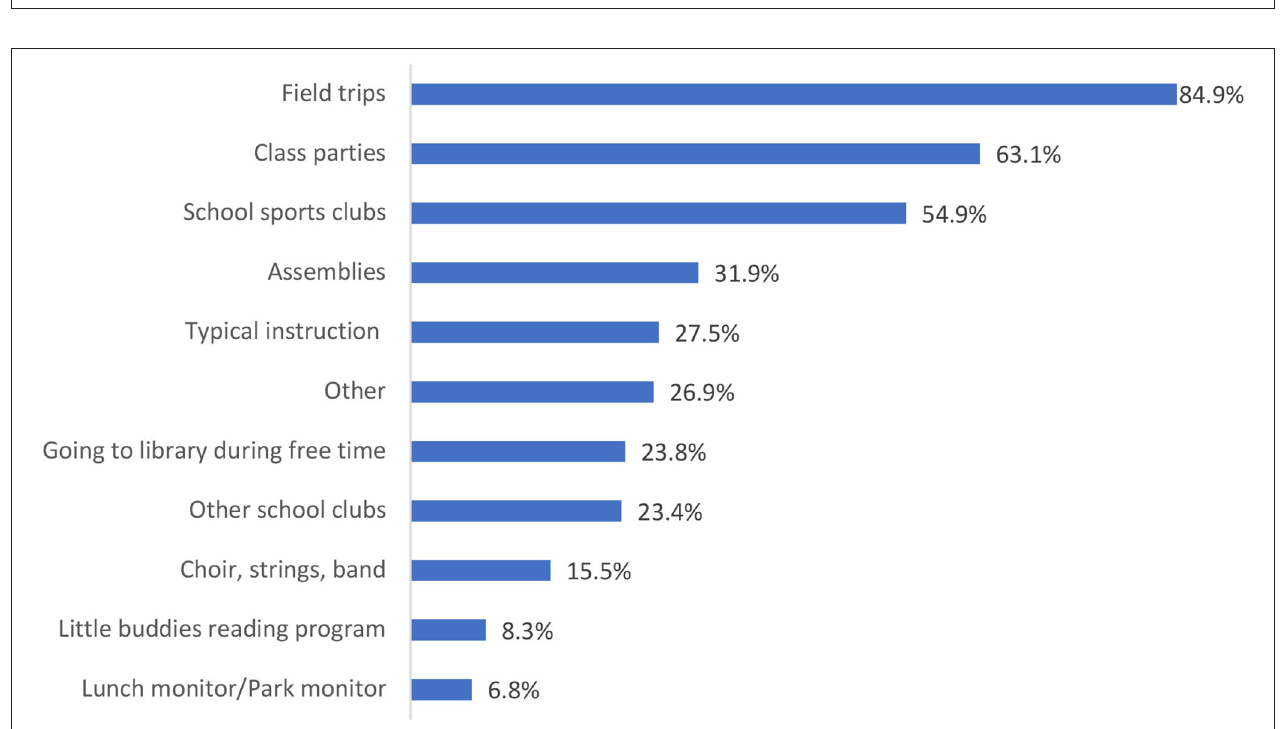
FIGURE 4 | Activities that students missed most at school during the COVID-19 pandemic.